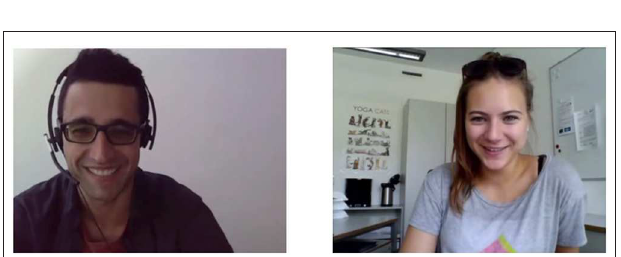
FIGURE 1 | Screenshots taken from sample video chats in the SEWA corpus (German